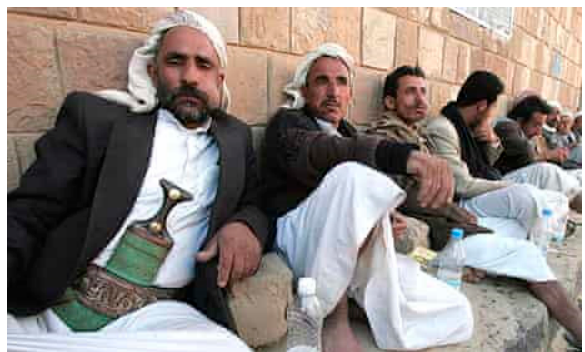
Figure 7. Yemeni men relax in the shade chewing qat, a mild drug used by most Yemenis. Photograph: Cris Bouroncle/AFP/Getty Images.